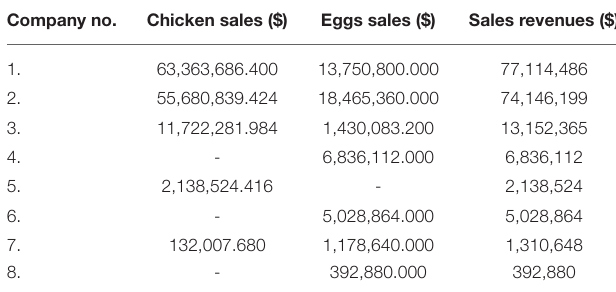
TABLE 3 | Sale revenues of the poultry farms in